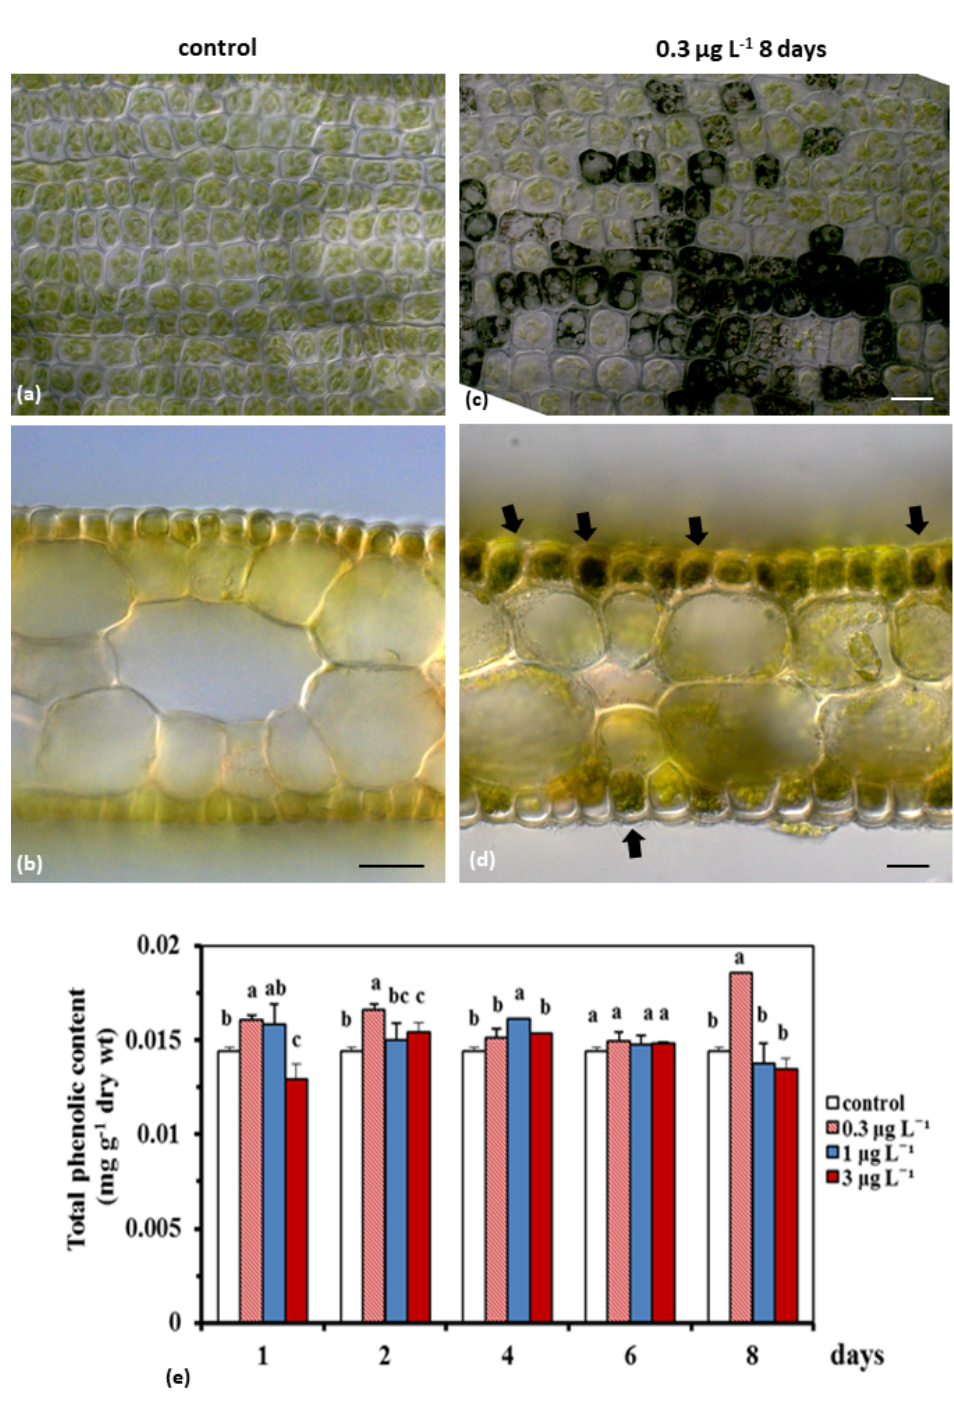
Figure 4. Indicative images of DIC micrographs of control ( a , b ) and BPA-treated (0.3 µ g L − 1 1 for 8 days) ( c , d ) Cymodocea nodosa leaves. Under BPA effect, epidermal cells with dark content appeared (black arrows) as indicated in both surface ( a , c ), and cross ( b , d ) leaf sections. Changes in total phenolic content in Cymodocea nodosa leaves, at 0.3, 1 and 3 µ g L − 1 BPA treatments and in the control, exposed for 1, 2, 4, 6 and 8 days; mean ± SE from three subsamples ( e ). Different letters express significantly different values between treatments and the control and between treatments (Mann–Whitney U–test; p <